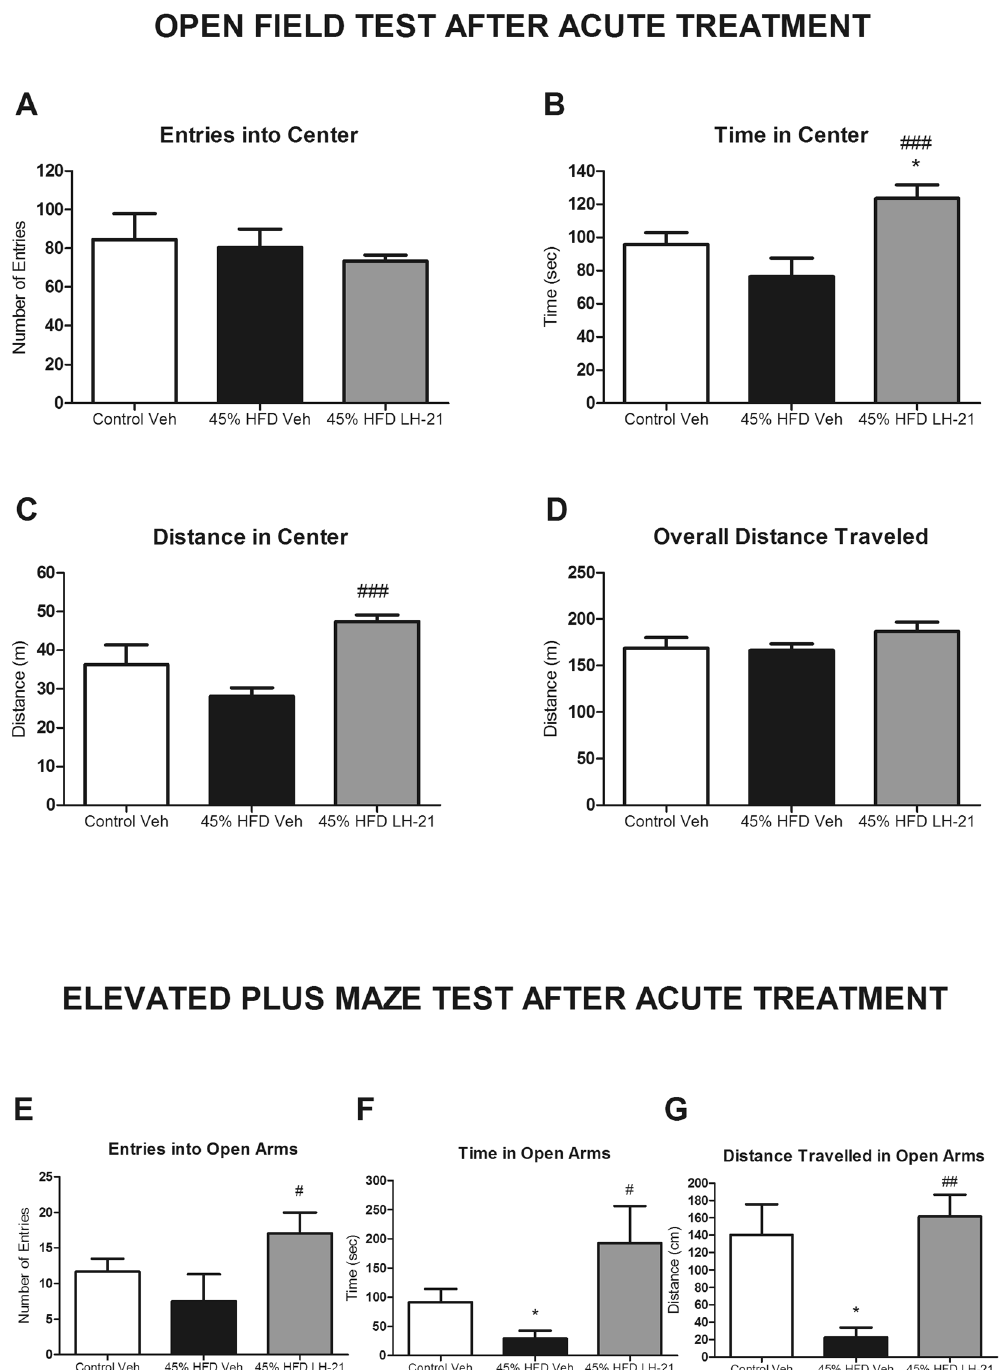
Figure 4. Behavioural study in obese pre-diabetic mice acutely treated with LH-21. ( A – D ) Exploratory activity was recorded for ten minutes in the open field maze in control, 45% HFD-vehicle and 45% HFD-LH-21 mice. Entries into center ( A ), time in center ( B ), distance in center ( C ) and overall distance travelled ( D ) were monitored. No changes were detected between control and 45% HFD-vehicle mice. However, acute LH-21 injections increased exploratory activity in the center in 45% HFD mice, as assessed by increased time and distance travelled in center; ( E – G ) Anxiety was analysed by the elevated plus maze test in these mice. Entries into open arm ( E ), time in open arms ( F ) and distance travelled in open arms ( G ) were recorded for five minutes. 45% HFD-vehicle mice showed an anxiety-like behaviour with decreased time in open arms and distance travelled in open arms when compared to control mice. Acute injections of LH-21 in 45% HFD mice increased the number of entries into open arms and reverted the HFD-induced decrease in time in open arms and distance travelled in open arms. n = 8–10 mice each group. One-way ANOVA and Bonferroni’s post-test, * p < 0.05 versus control; # p < 0.05, ## p < 0.01 versus 45%